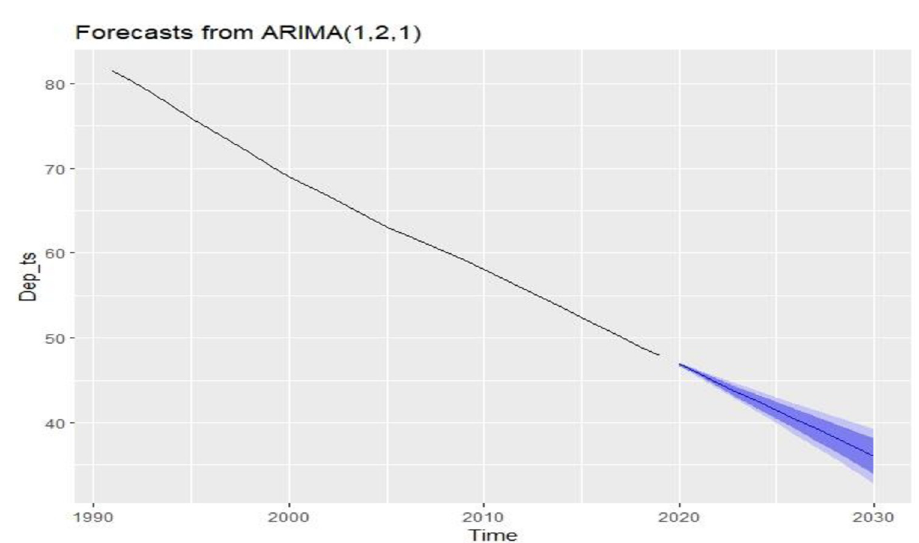
Fig 9. Future condition of age dependency ratio in